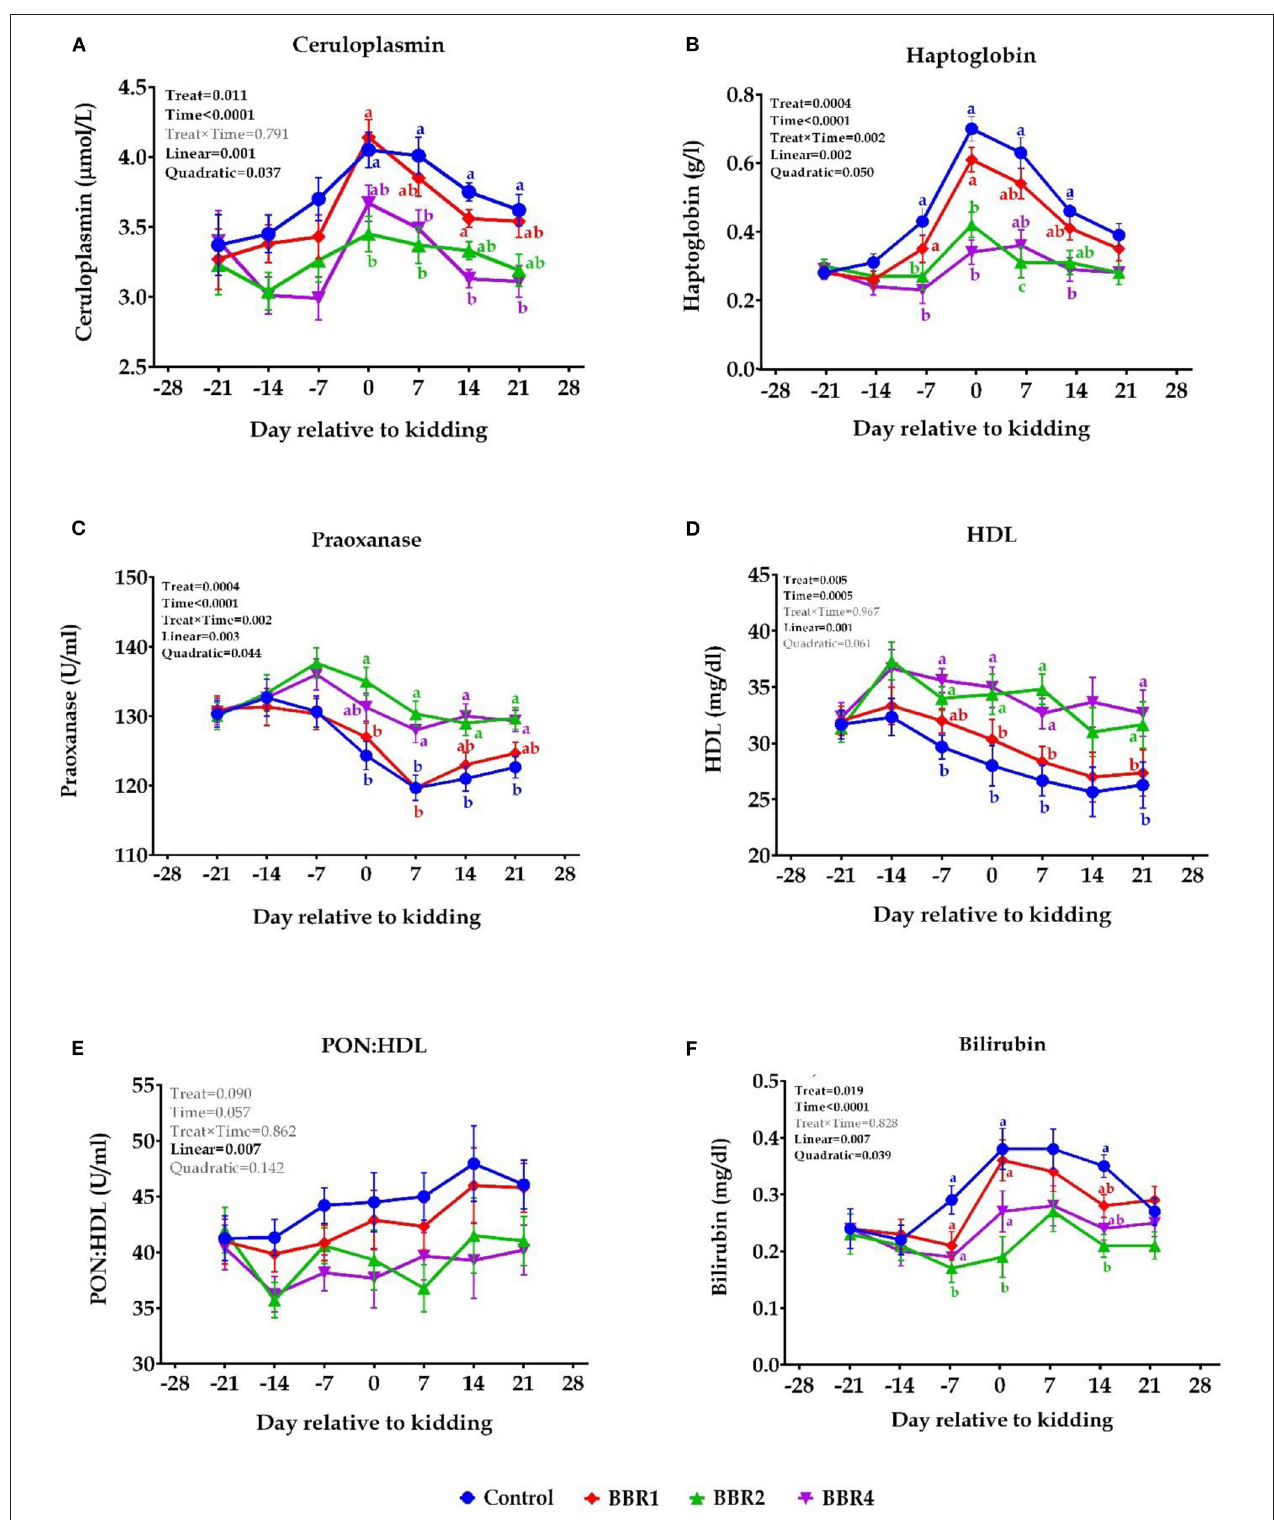
FIGURE 3 | Means ( ± SEM) of biomarkers of positive acute-phase protein [ (A) ceruloplasmin and (B) haptoglobin] and negative-acute phase protein [ (C) paraoxonase, (D) HDL, (E) paraoxonase/HDL, and (F) bilirubin] in Saanen dairy goats supplemented with different levels of BBR during the transition period. a,b Values with different superscript letters at the same time point are significantly different ( P ≤